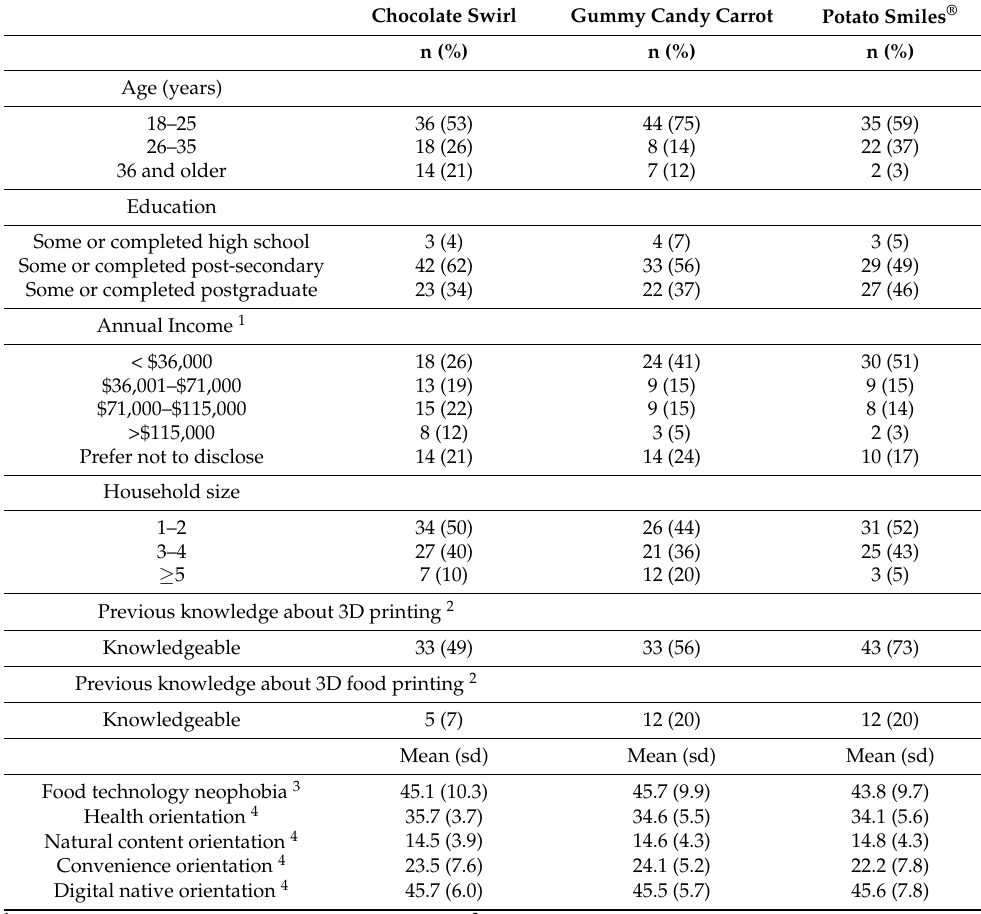
Table 1. Participant demographics, food technology neophobia, and attitude orientation scores for the chocolate swirl (n = 68), gummy candy carrot (n = 59), and potato Smiles ® (n = 59)